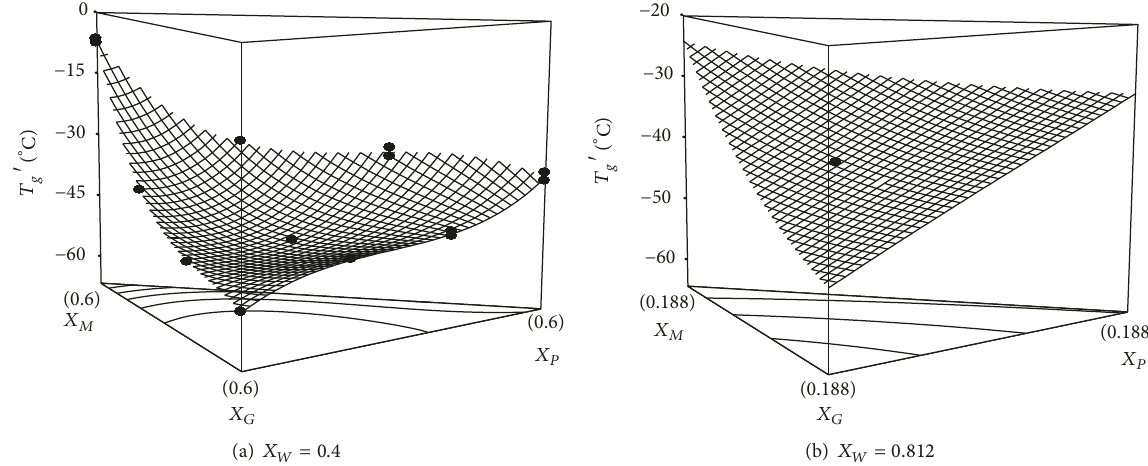
󸀠 for different cryoprotectant solutions: g